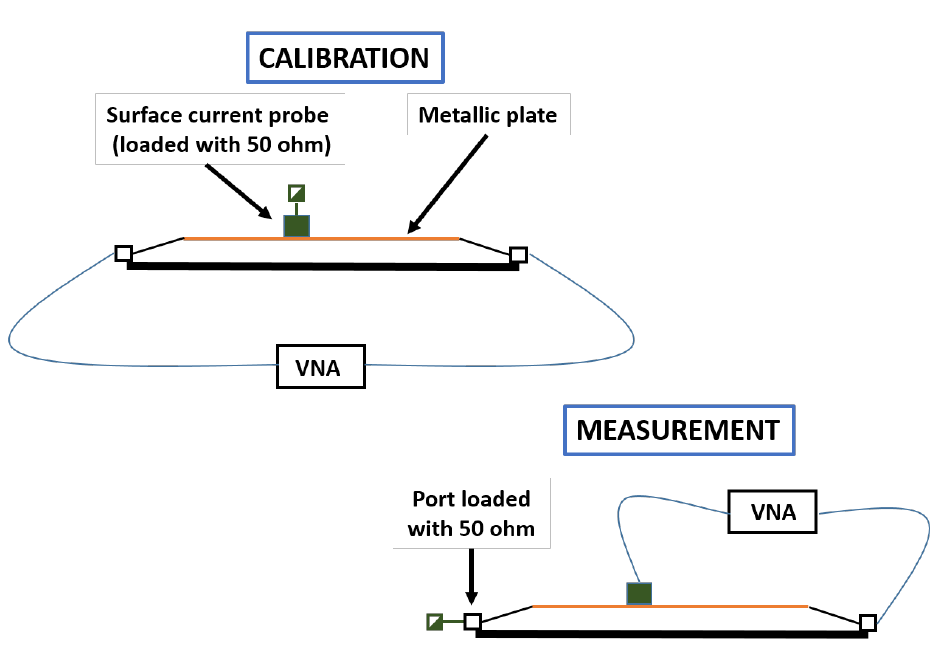
Figure 6. Surface current measurement and calibration with a multi-gap loop B-dot ground plane sensor on the samples surface under test.